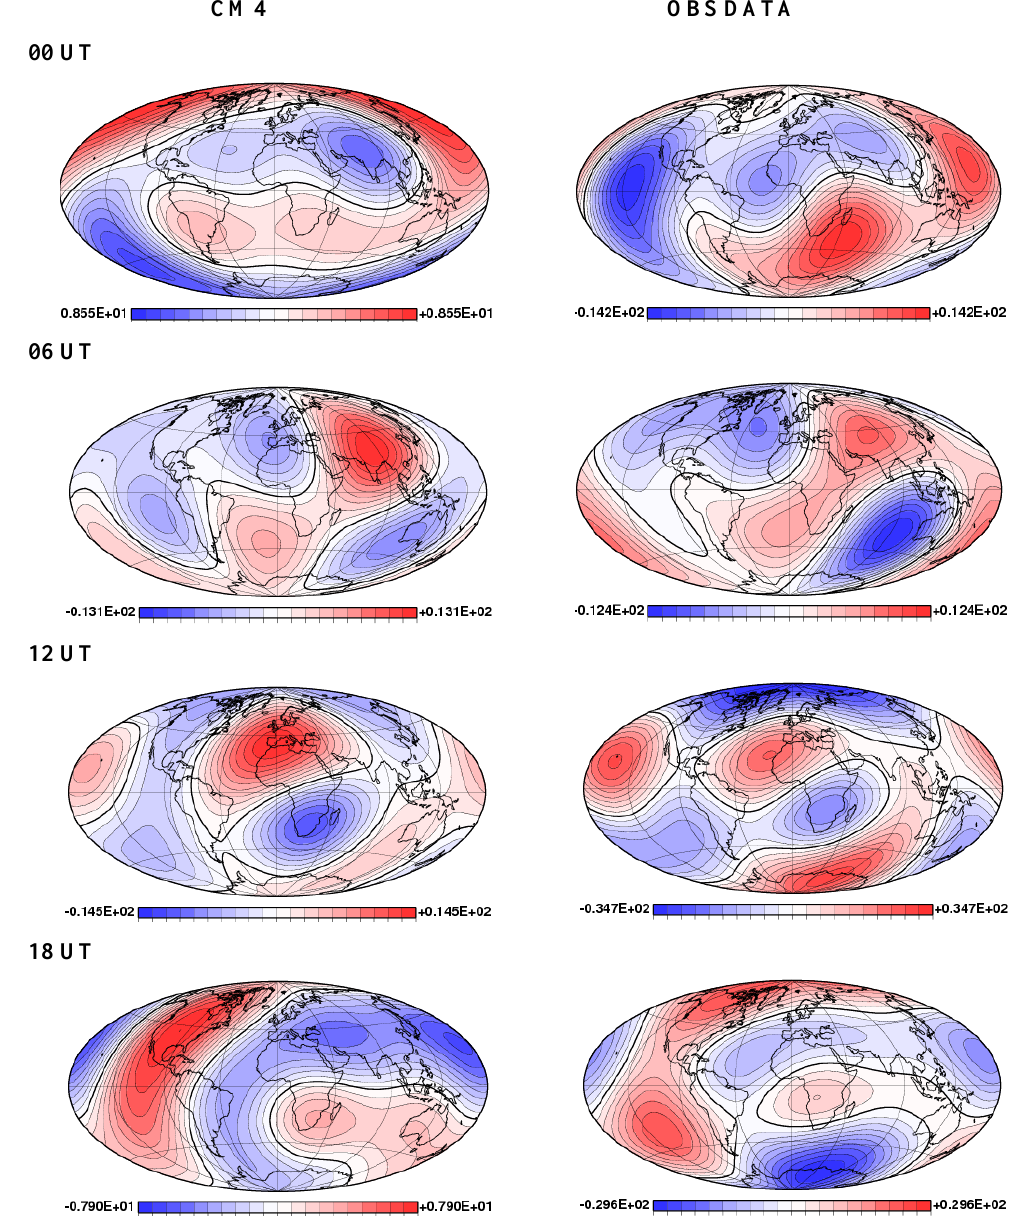
Figure 6. Similar to Fig. 5 but for spherical harmonic truncation up to 3, n = 3. More features start to be revealed.